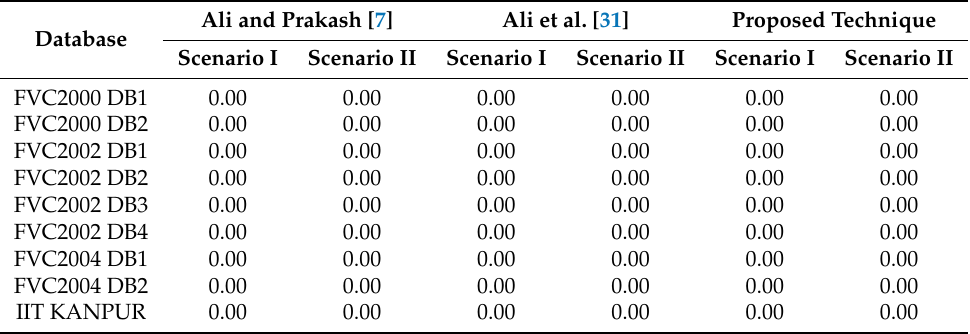
Table 1. Revoked template attack (successful attacks in percentage), proposed technique can over- come it